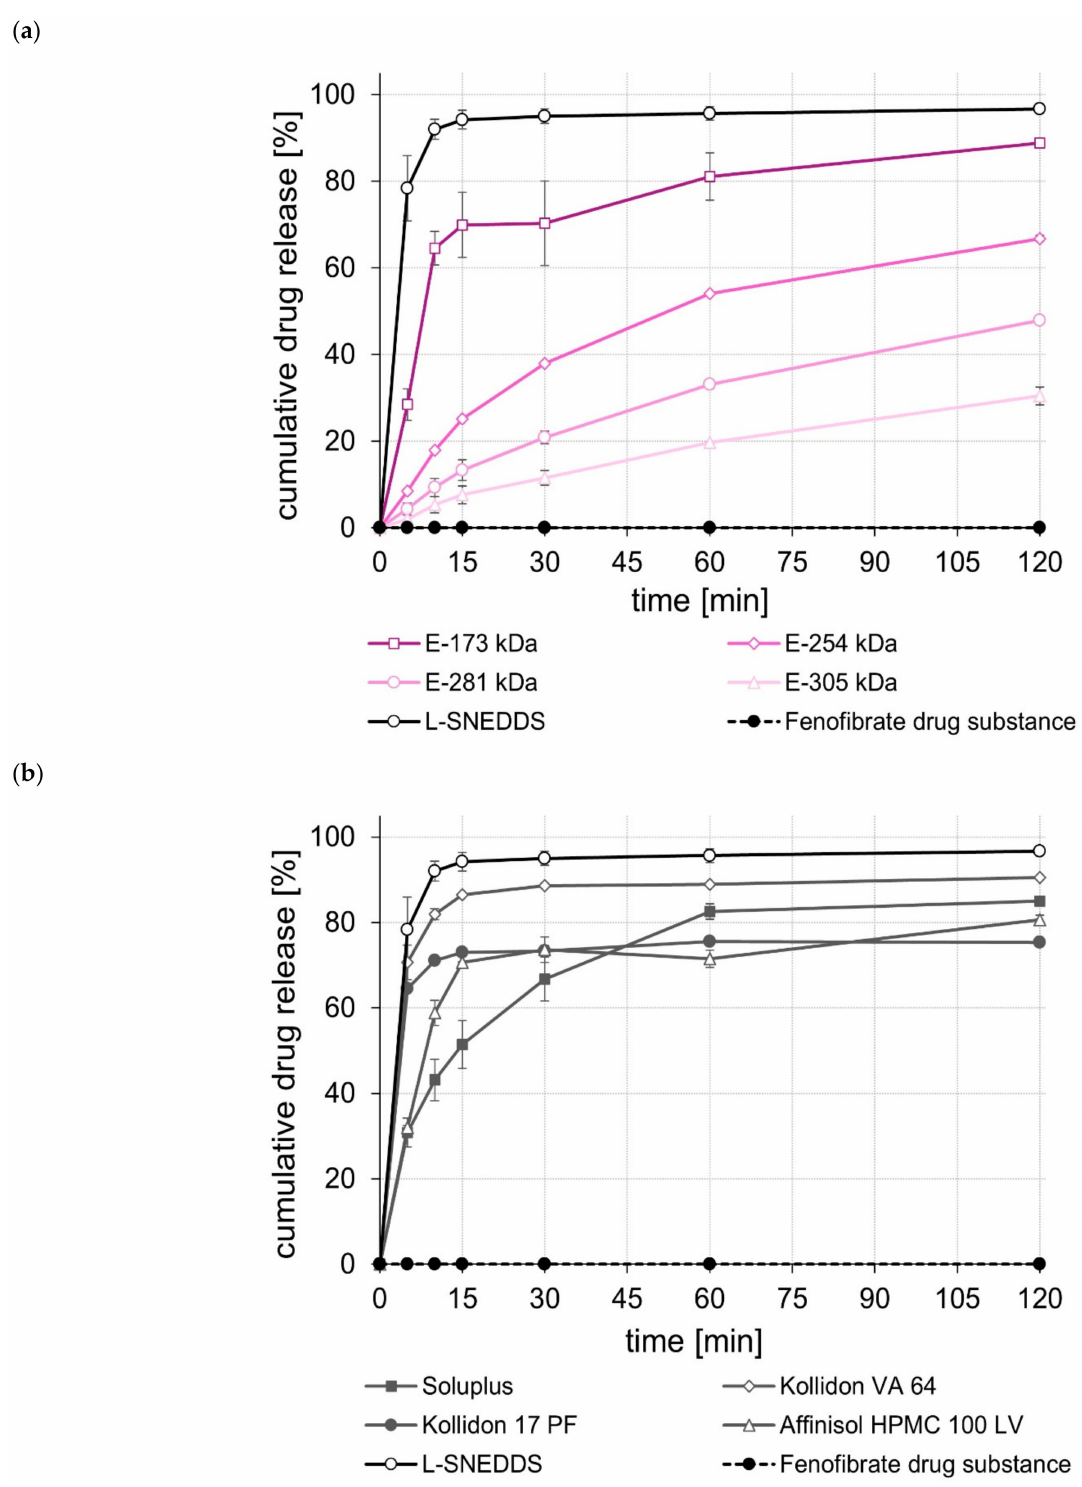
Figure 3. Dissolution profiles of the fenofibrate drug substance and fenofibrate L- and S-SNEDDS based on ModE ( a ), as well as the fenofibrate drug substance and fenofibrate L- and S-SNEDDS based on other marketed (co)polymers ( b ) in 500 mL 0.1 M HCl in USP apparatus II. Each value designates the mean ± S.D. ( n =